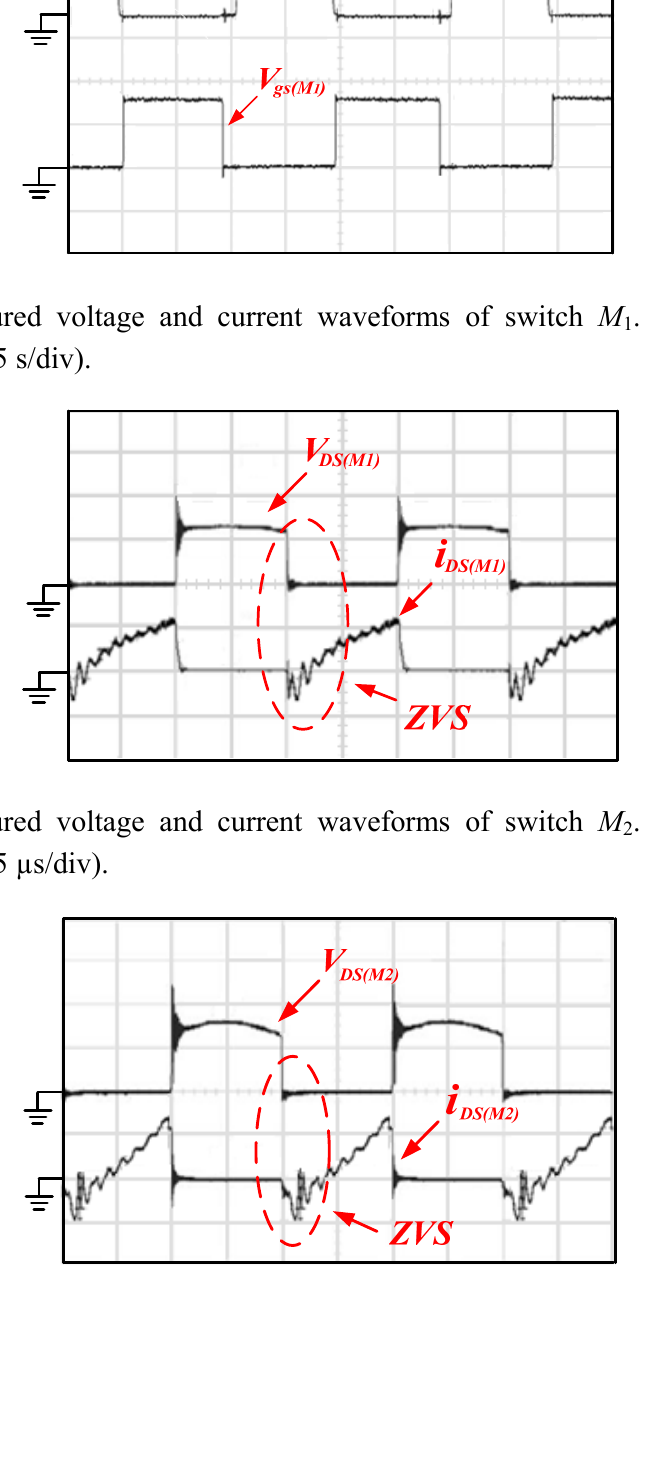
and auxiliary switch M 1